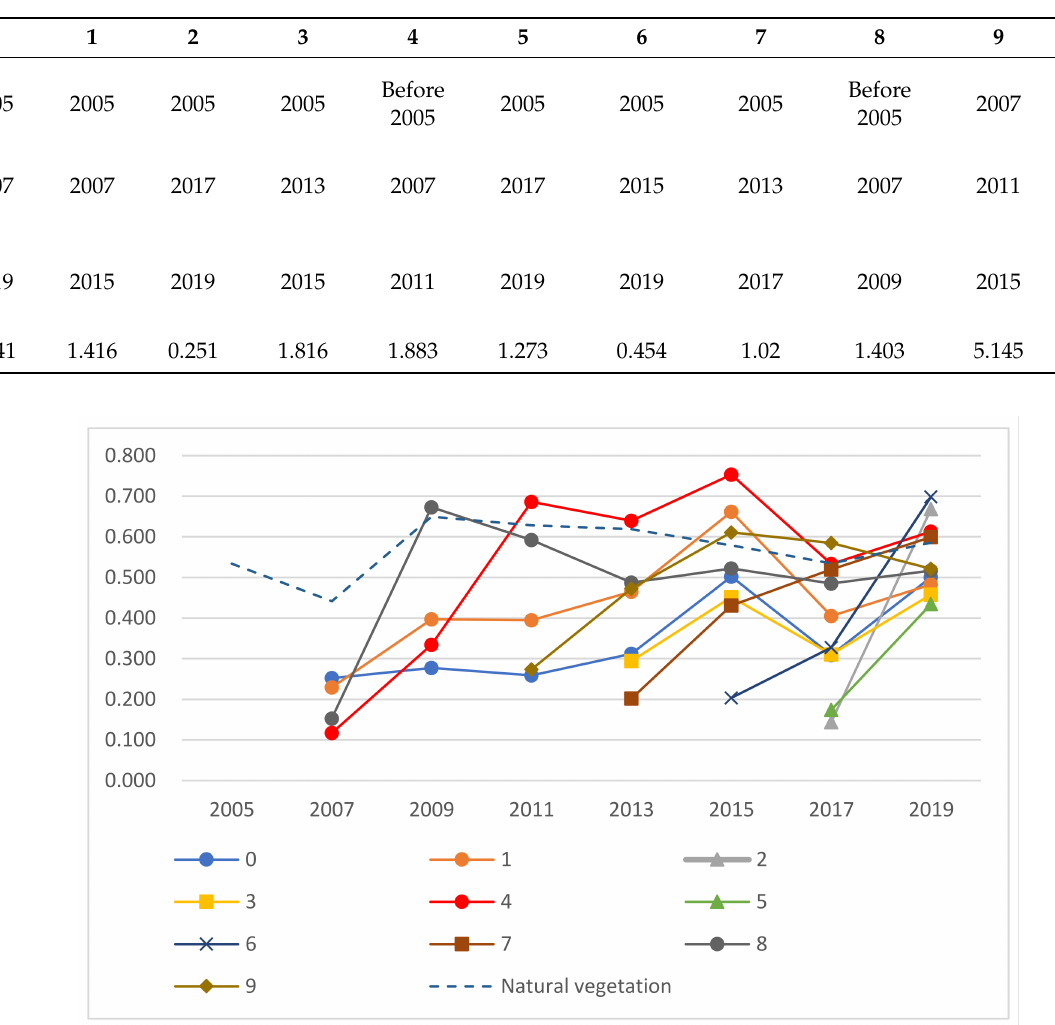
Figure 9. Changes in vegetation coverage in the vegetation restoration area (C–V) from 2005 to